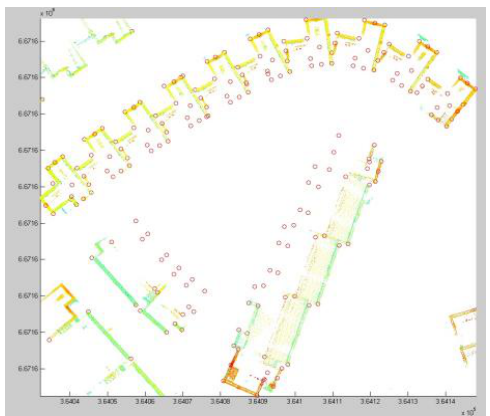
Figure 8. Data fusion of building roofs from UAV image and building walls from MLS. The pink circles are the building roof points whereas the other points are from MLS.